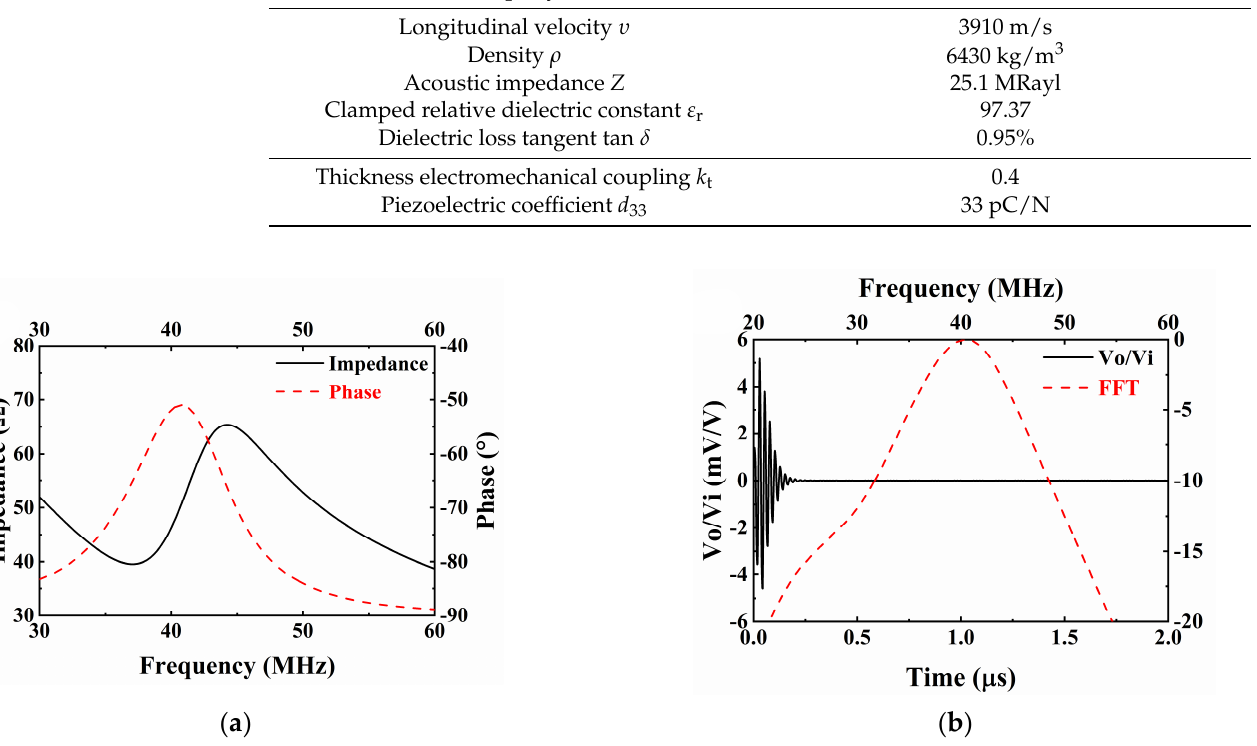
Figure 3. Modeling results of NBT-Nb-Mn single element transducer from KLM model-based simulation software PiezoCAD: ( a ) impedance simulation results; ( b ) pulse-echo simulation results.